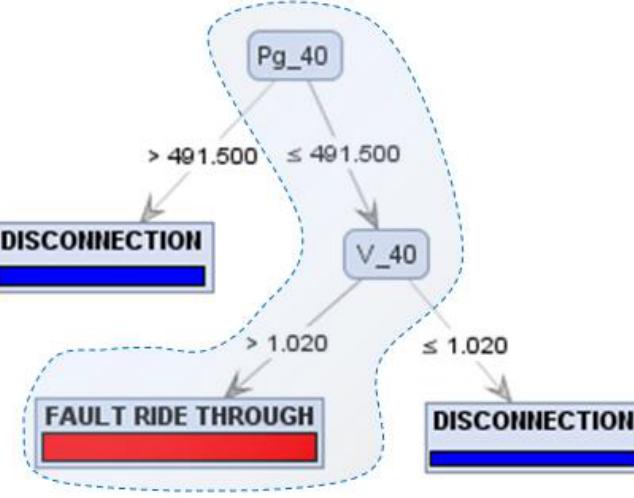
Figure 15. Decision tree branch for the complete topology.